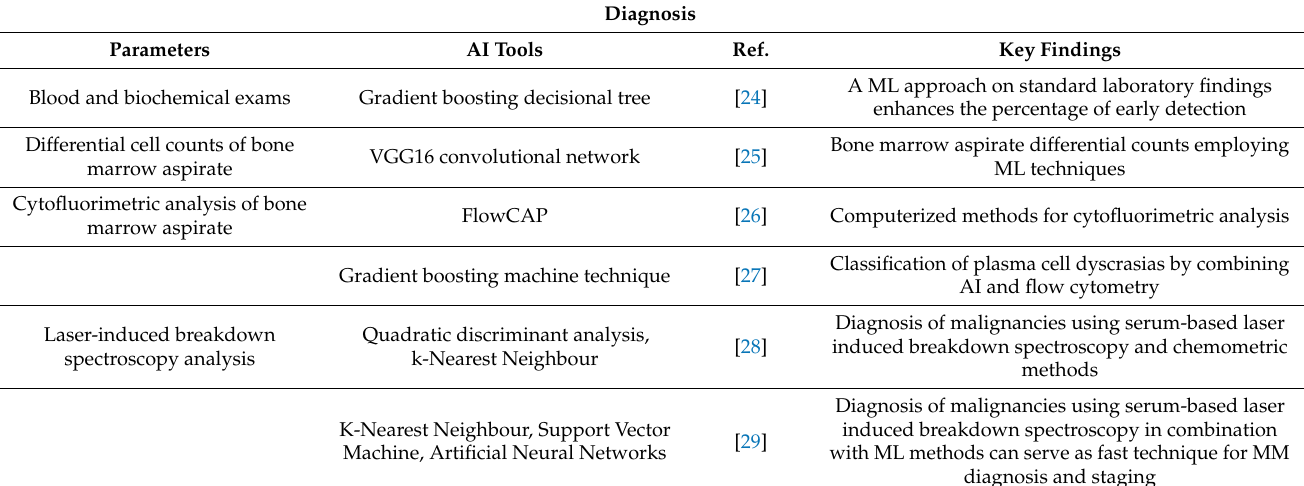
Table 1. Artificial intelligence (AI) applications in multiple myeloma diagnosis, and bone lesions